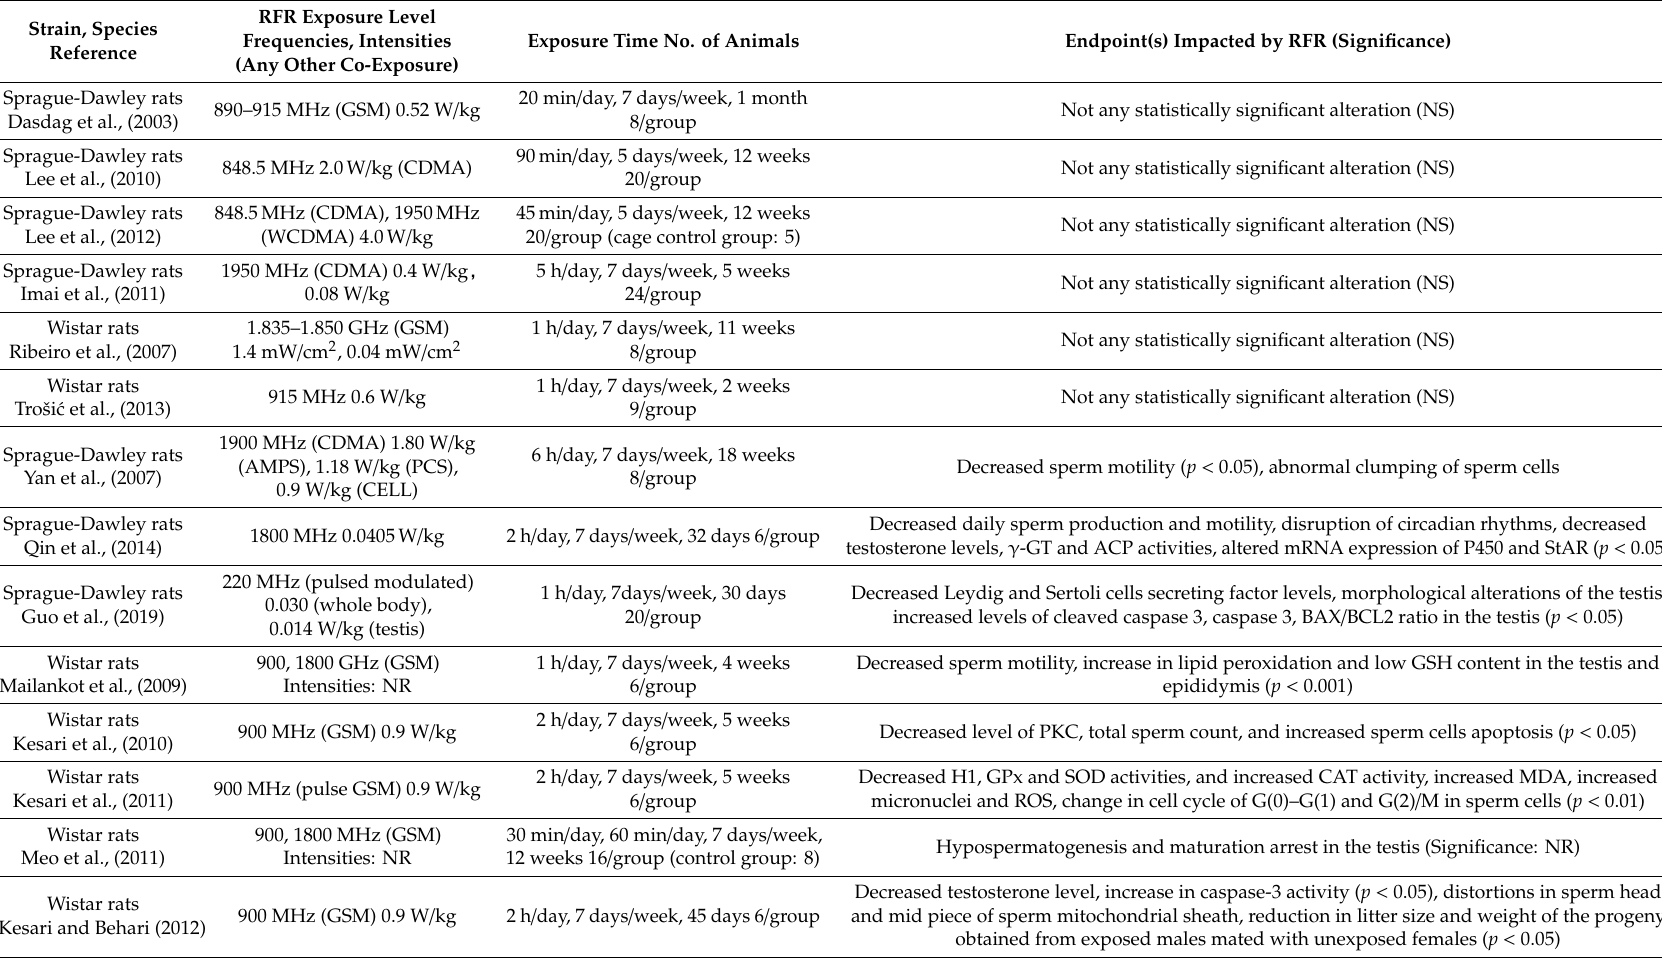
Table 4. Male reproductive studies in rats exposed to